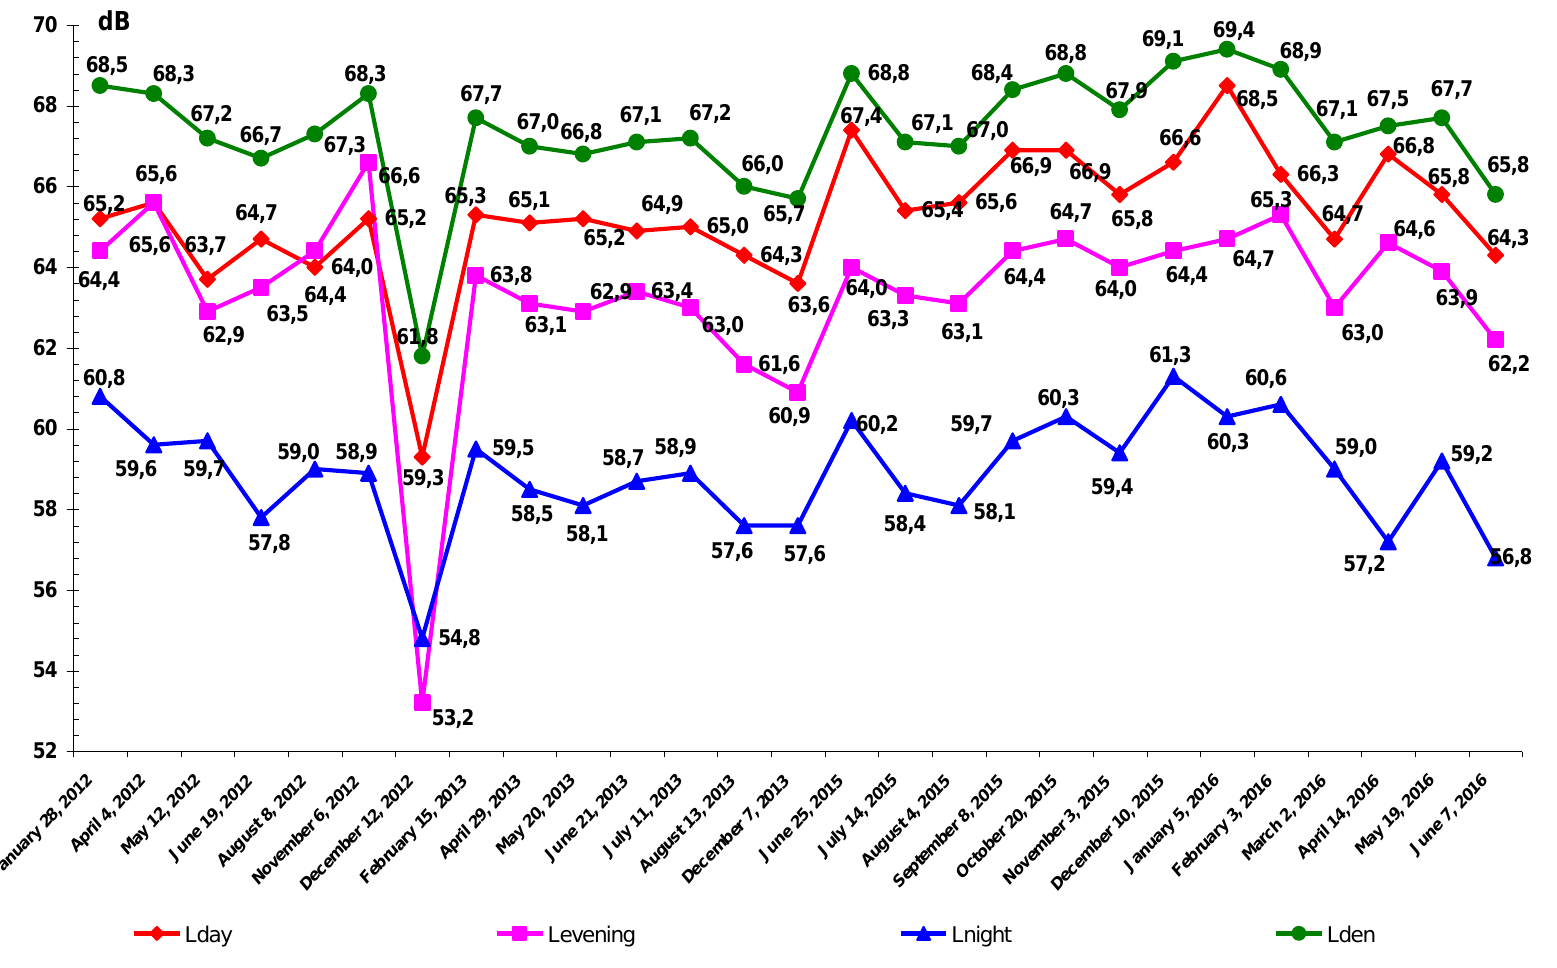
Chart 1. Values of basic noise indicators (L in the "zone of the city center and city roads" of the City of Novi Sad during the period 2012 −